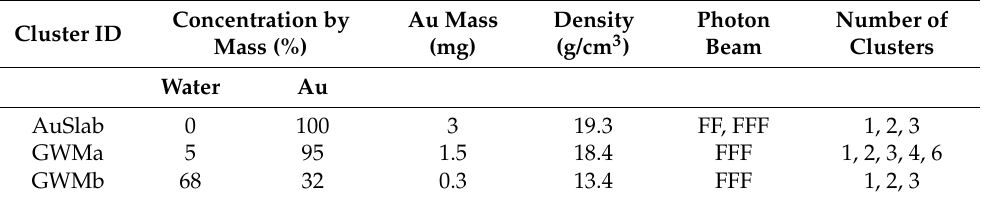
Table 3. Simulated 100 nm clusters characteristics and irradiation conditions for different concentra- tions. Photon field size was 5 × 5 cm 2 , and the depth in water for the last slab was 2 cm.